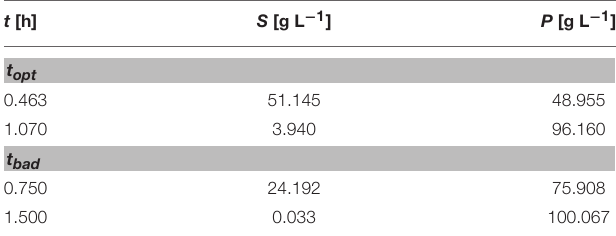
TABLE 2 | Concentrations for measurement times t opt and t bad ..